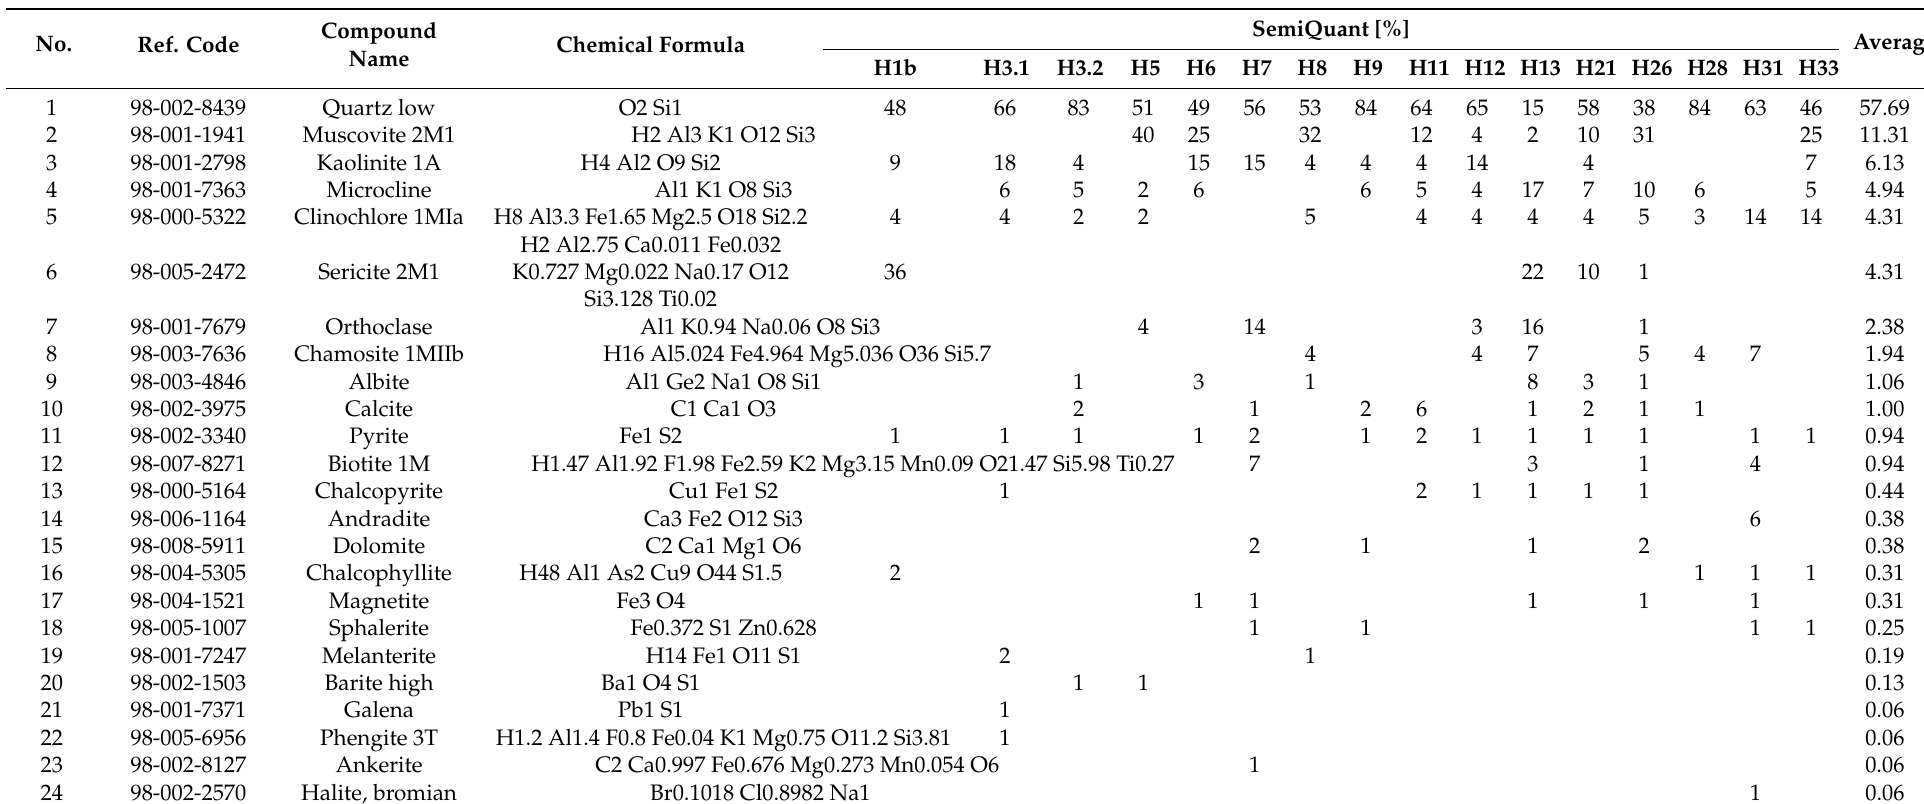
Table A2. XRD analyses of representative samples from alteration zone-1 (sericite–quartz–chlorite ± kaolinite ±